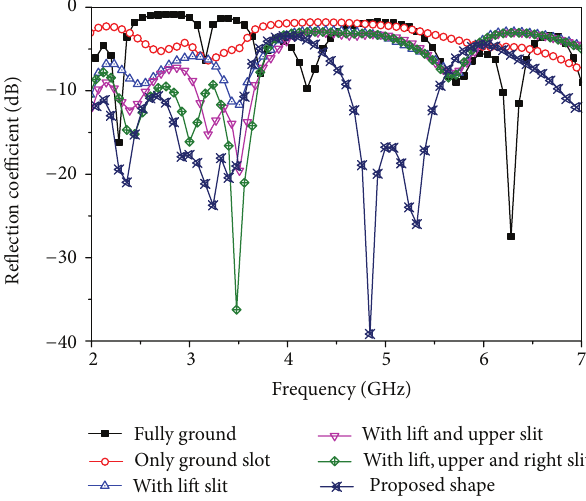
Figure 8: Effect of reflection coefficient for the different length of ground slit 𝐿 2 .